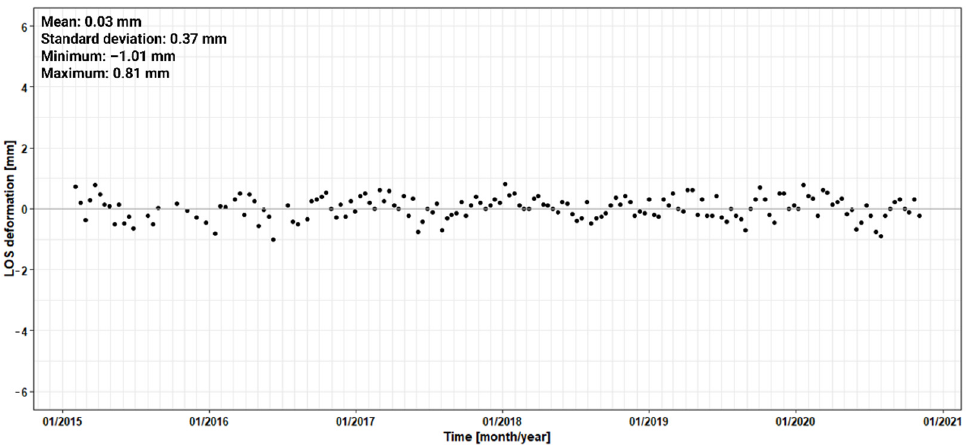
Figure 10. Deformation profile of a PS point located distant from the Moehne dam. Shown are the LOS